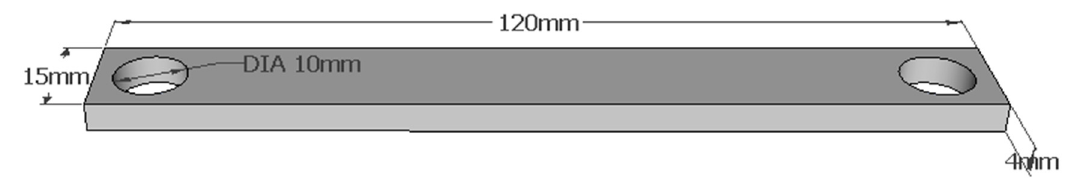
Figure 1. The geometry of tensile test specimen.